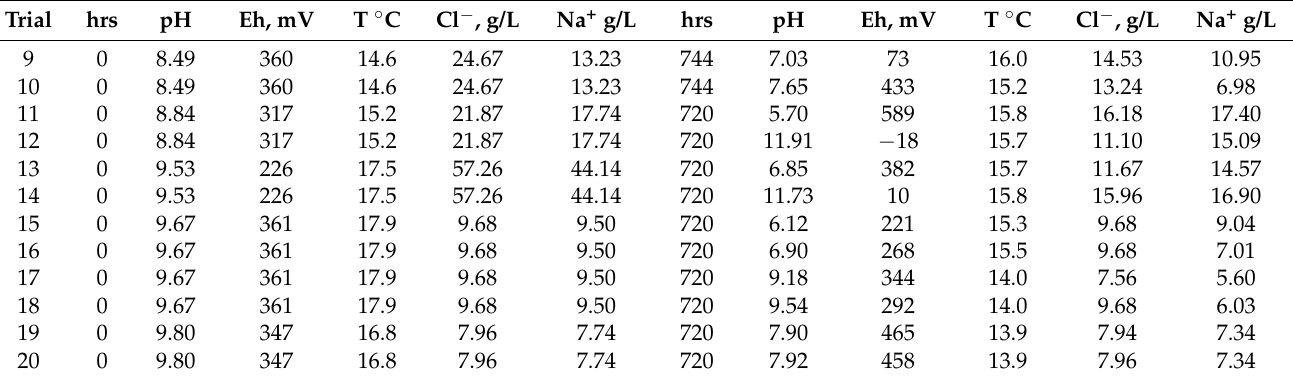
Table A10. Product water composition immediately following dilution and at 24 to 72 h